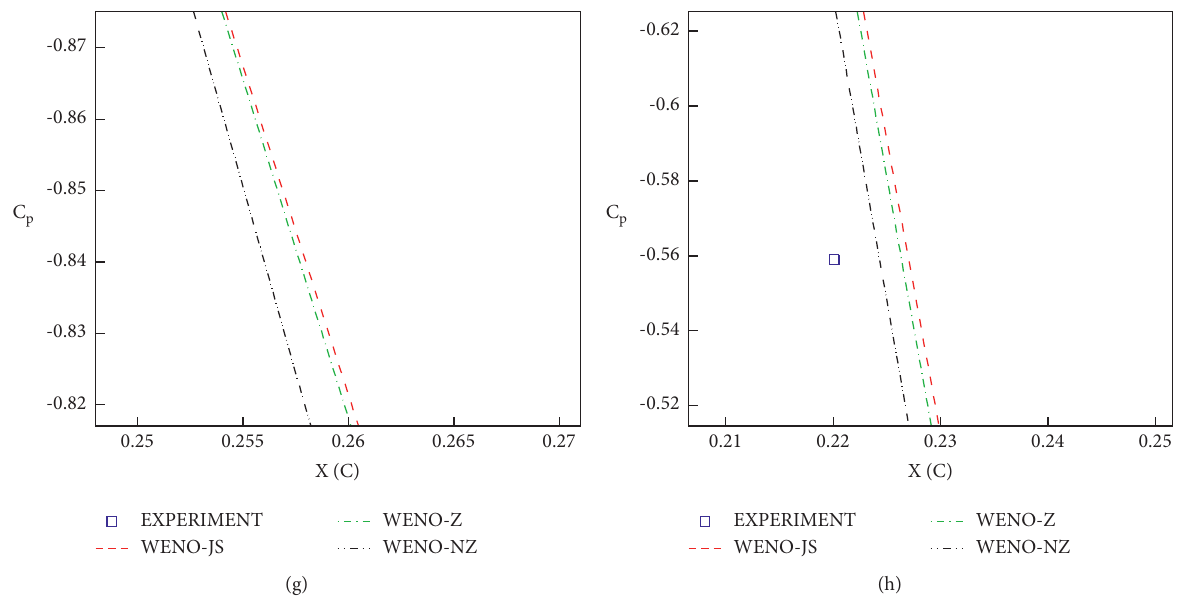
Figure 12: Pressure coefficients at the wing surface about the transonic flow over the ONERA-M6 wing.